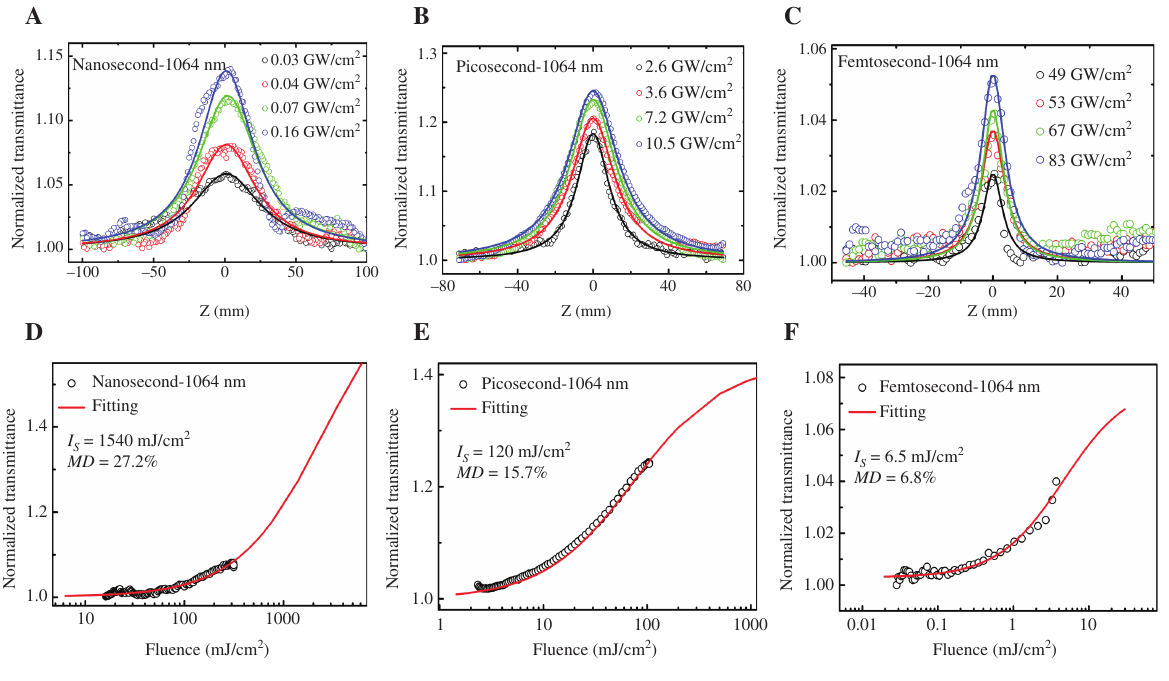
Figure 3: Pulse duration dependent nonlinear optical absorption of GeSe NPs. (A), (B) and (C) OA Z-scan measurements of GeSe NP dispersions at 1064 nm with different pulse durations of 7 ns, 10 ps, and 56 fs, respectively; (D), (E) and (F) normalized transmittance and input peak intensity for open aperture Z-scan measurements of GeSe NP dispersions with different pulse durations of 7 ns, 10 ps, and 56 fs,